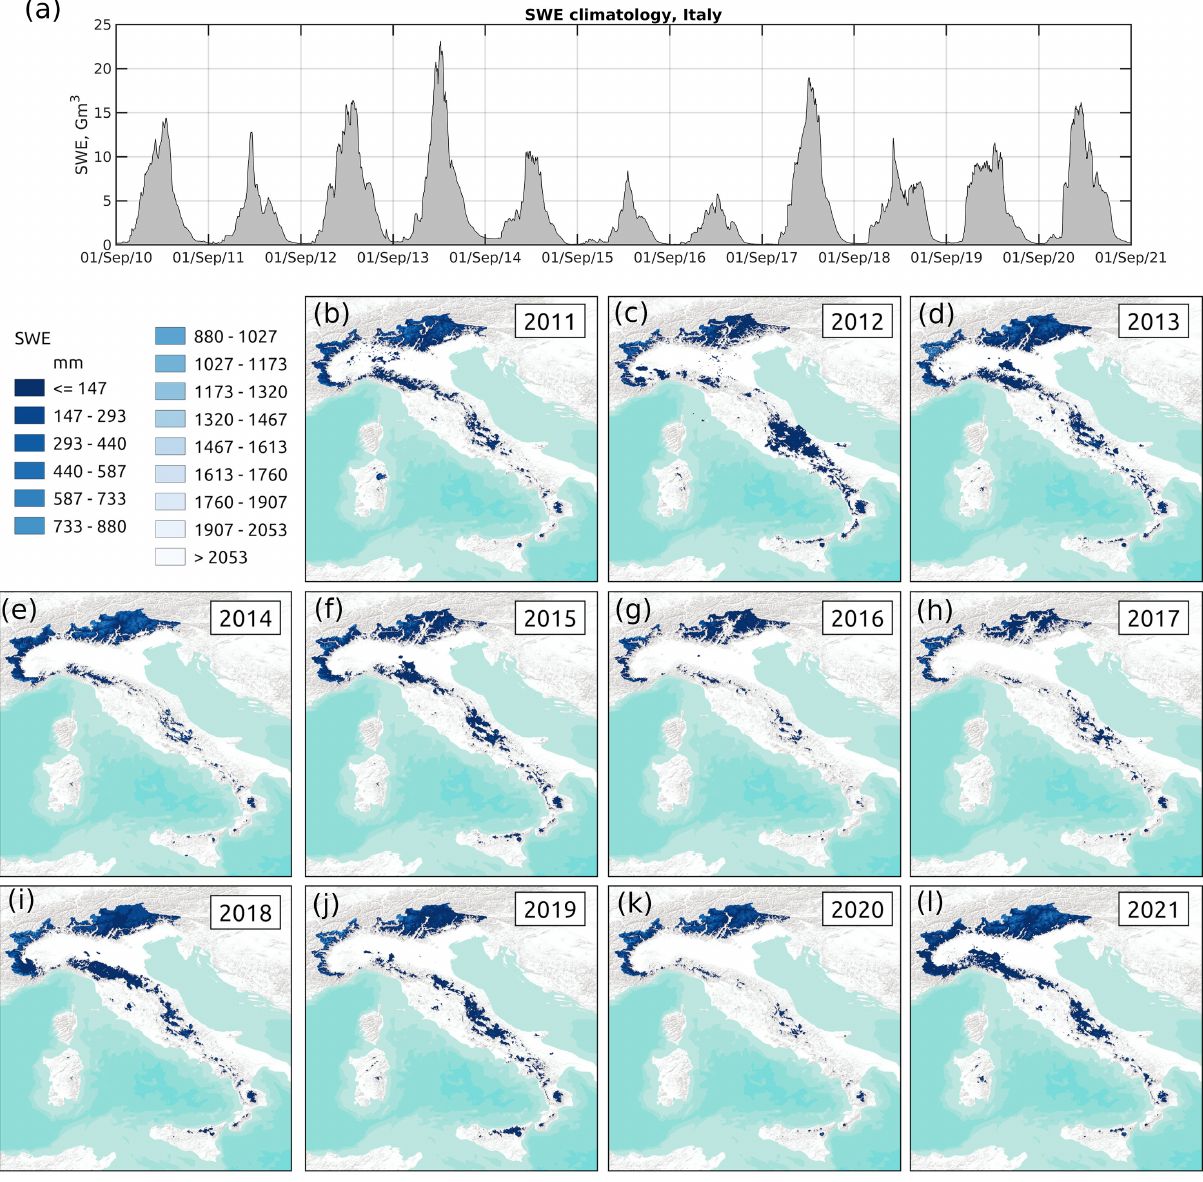
Figure 10. Example of use of IT-SNOW. (a) Spatially aggregated total daily SWE across Italy. (b–l) Mean annual SWE (November to June for water years 2011 to 2021). The background map is from Esri terrain. SWE in panel (a) is expressed in the form of total volume of water stored in snow (Gm 3 ; see Sect.